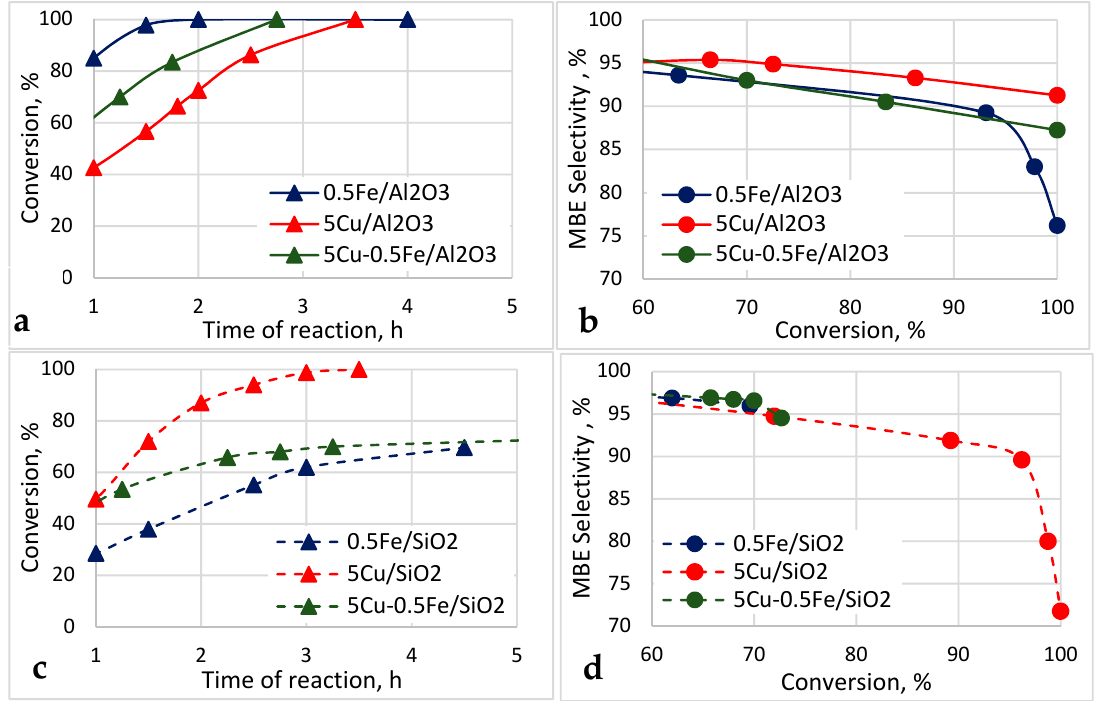
Figure 6. Time dependence of the MBY conversion ( a , c ) and the selectivity to MBE ( b , d ) for the 0.5Cu-5Fe samples supported on Al 2 O 3 and SiO 2 .